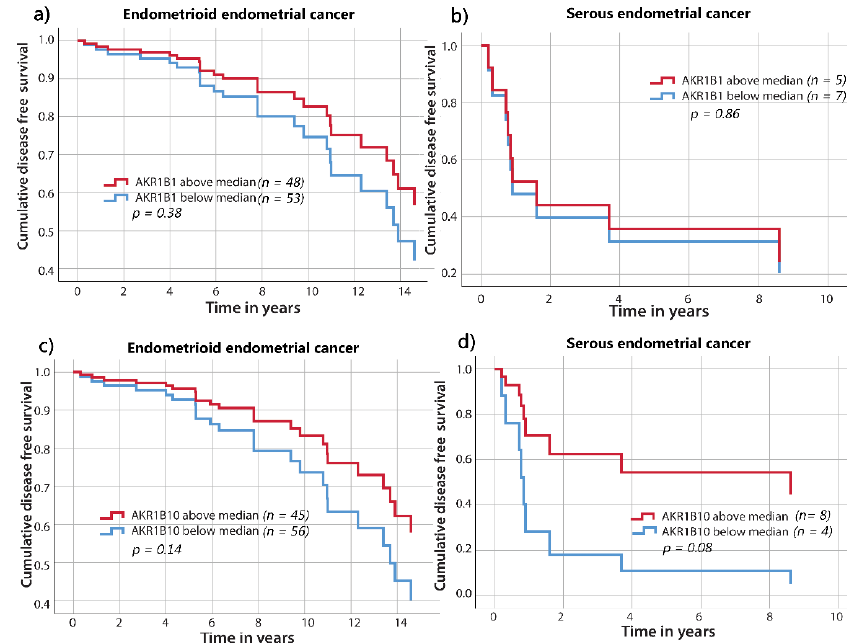
Figure 7. Disease-free survival curves for AKR1B1 and AKR1B10 in endometrioid and serous EC. AKR1B1 in patients with ( a ) endometrioid EC ( p = 0.38) and ( b ) serous EC ( p = 0.86). AKR1B10 in patients with ( c ) endometrioid EC ( p = 0.14) and ( d ) serous EC ( p = 0.08). The groups are separated according to their median values. Time on x axis represents time elapsed since initial diagnosis. AKR1B1: aldo-keto reductase family 1 member B1; AKR1B10: aldo-keto reductase family 1 member B10.